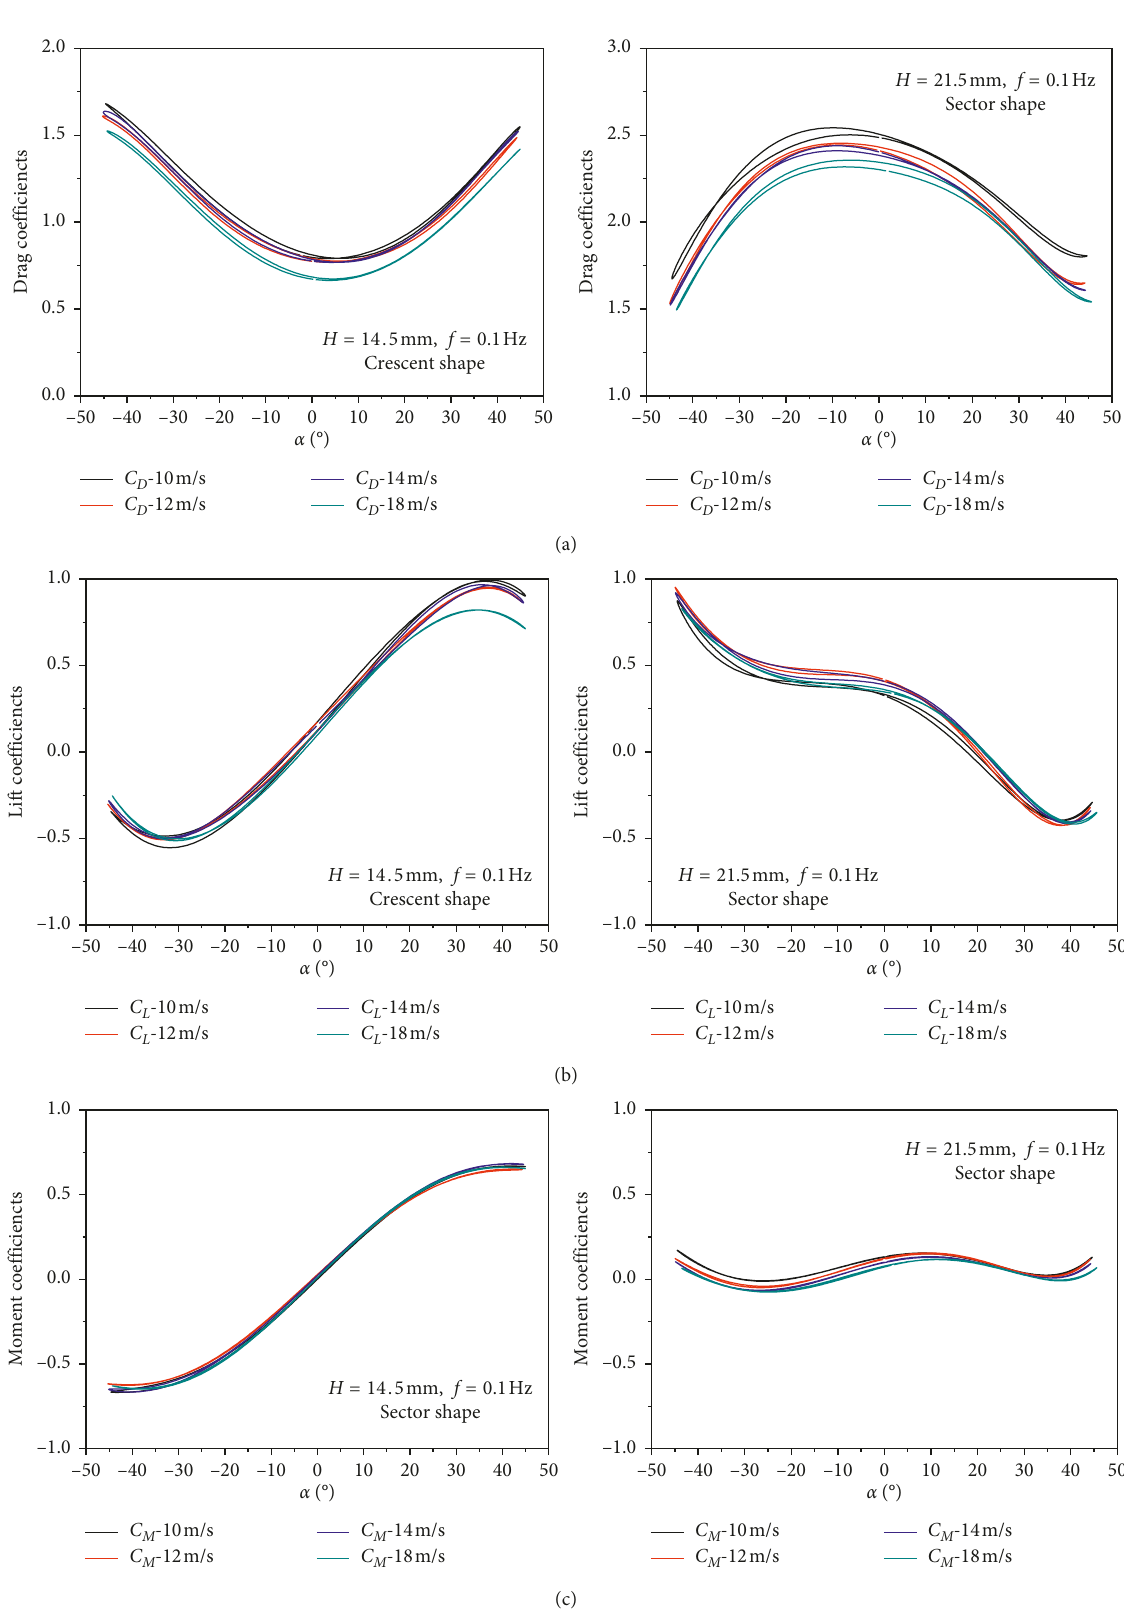
Figure 8: The unsteady aerodynamic coefficients of iced subconductor 1 under different wind velocities: (a) drag coefficients; (b) lift coefficients; (c) moment